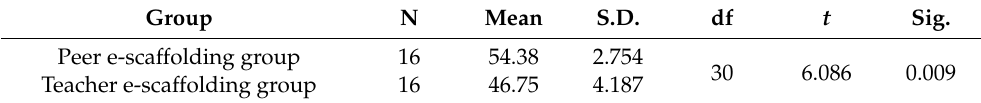
Table 4. Independent-samples t -test of the skills post-intervention assessment. Group N Mean S.D. df t Sig. Peer e-scaffolding group